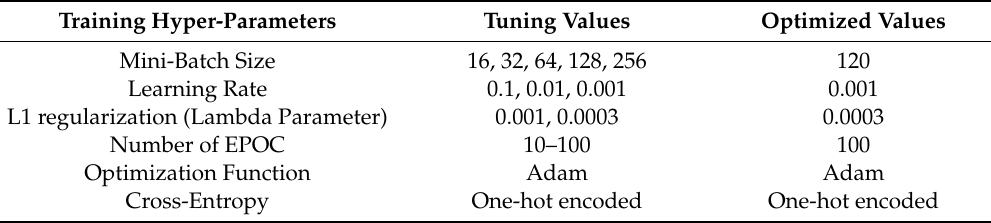
Table 2. Training hyper-parameters (Tuning values and optimized